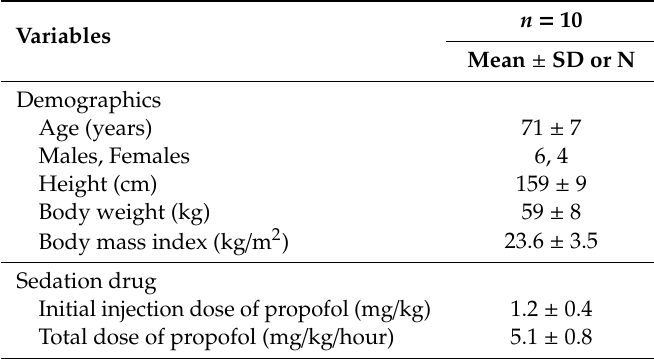
Table 1. Patients’ characteristics and propofol doses for the